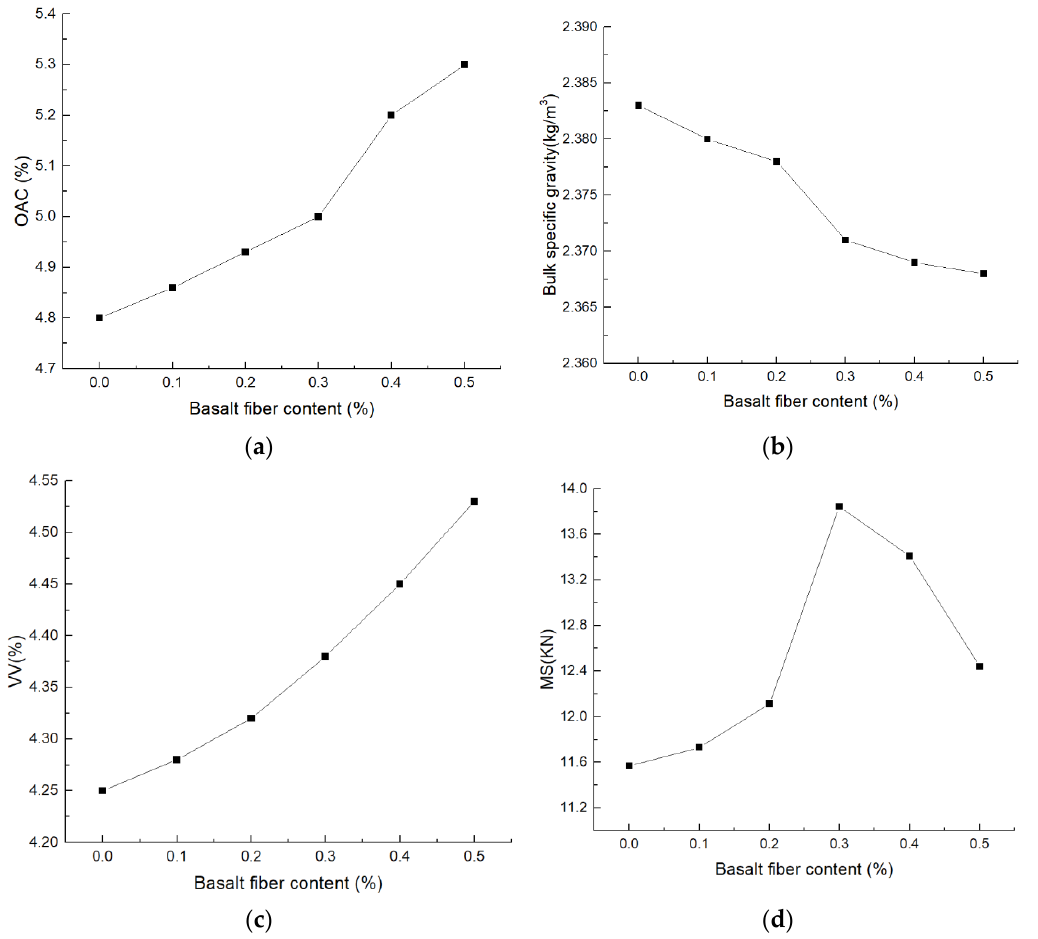
Figure 3. Marshall parameters of asphalt mixture containing various dosages of basalt fiber ( a ) optimum asphalt content (OAC), ( b ) bulk-specific gravity, ( c ) air voids (VV) and ( d ) Marshall stability (MS).